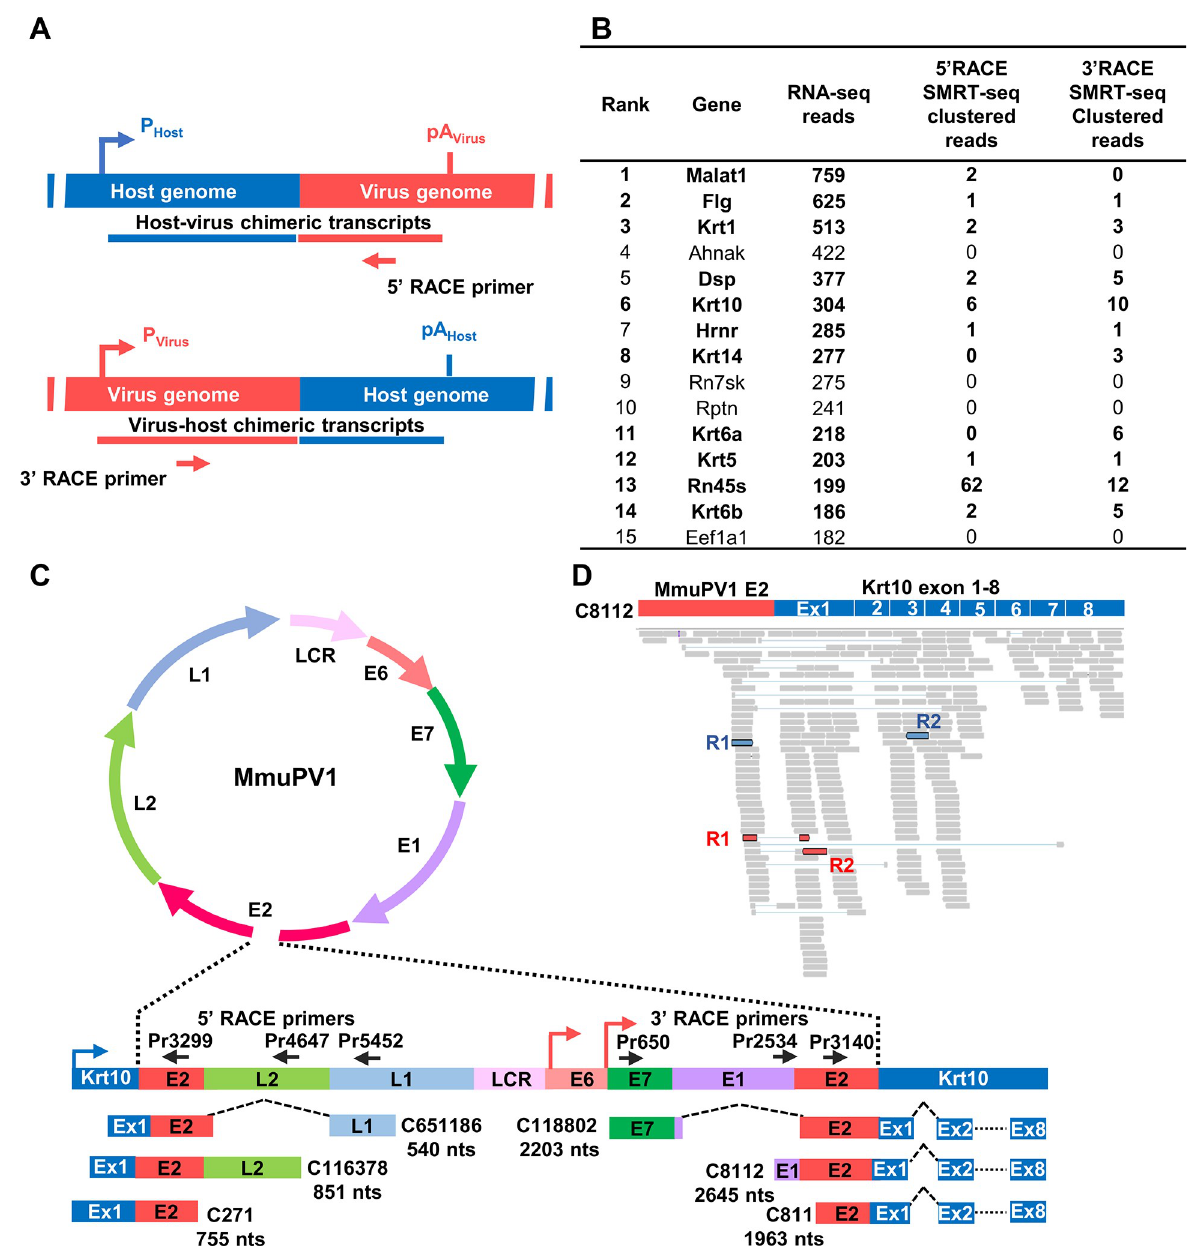
Fig 3. Validation of MmuPV1 integration sites by 5’ and 3’ RACE in combination with SMRT-seq (single molecule real-time sequencing). A, Strategies used to validate MmuPV1 integration sites by 5’ RACE and 3’ RACE with virus-specific primers. The chimeric virus-host cDNA amplicons derived from both 5’ and 3’ RACE were sequenced by SMRT-seq. P virus or P host indicates the use of a viral or host promoter and pA host or pA virus indicates the use of a host or viral polyadenylation signal. B, Verification by RACE-SMRT-seq of the 15 most favored host genes with MmuPV1 integration (S1 Table) detected by RNA-seq. Genes detected by two methods are bolded. C, Examples of virus-host (Krt10) full-length chimeric transcripts detected by 5’ RACE-SMRT-seq and 3’ RACE-SMRT-seq. Virus primers (black arrows) used in the RACE reactions are shown above the linearized and integrated viral genome, with colored arrows for host (blue) and viral (pink) promoters. Below are the detected chimeric, full-length virus-host RNA transcripts, with the name and estimated size in nts (after RNA splicing) given on the right or left side. D, RNA-seq reads-coverage for the virus-Krt10 chimeric transcript C8112 identified by 3’ RACE-SMRT-seq and visualized by IGV software. The representative chimeric junction reads (red) and chimeric paired reads (blue) from the RNA-seq data are highlighted.